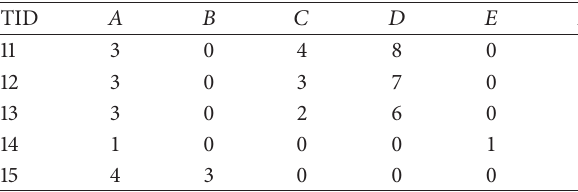
Table 3: Constructed EUCS structure. Table 4: Five inserted transactions.